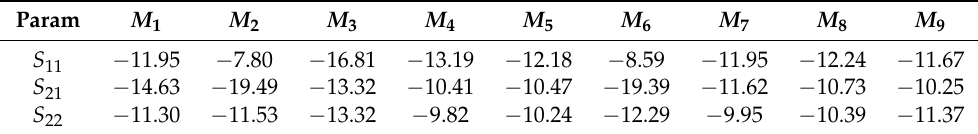
Table 2. Antenna port parameters at f c